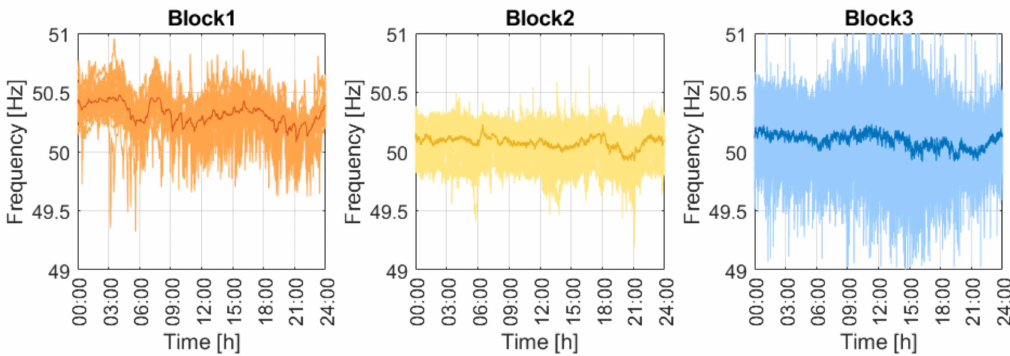
Figure 3. The distribution of frequency values of the three blocks. Block 1, Block 2 and Block 3 are probability distribution of the measured frequency over one month.